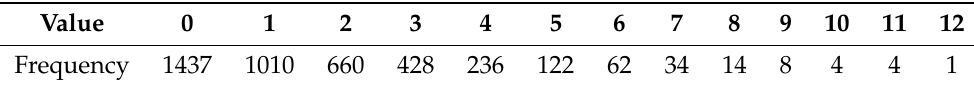
Table 3. Insurance claims